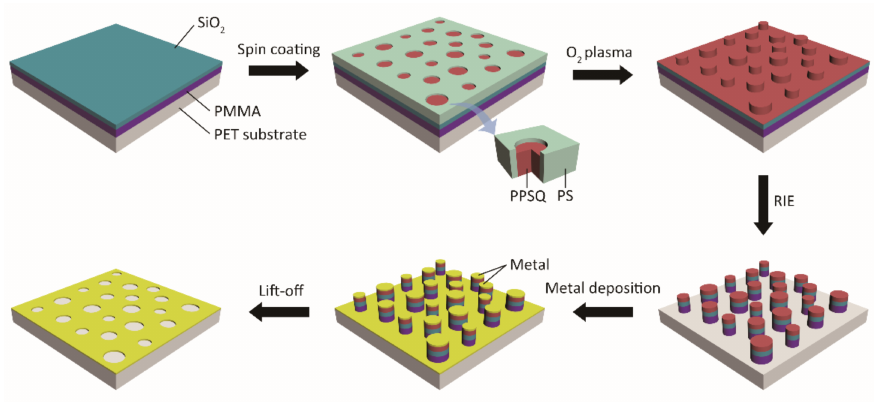
Scheme 1. Schematic illustration on fabrication process of metallic nanomesh film with amor- phous